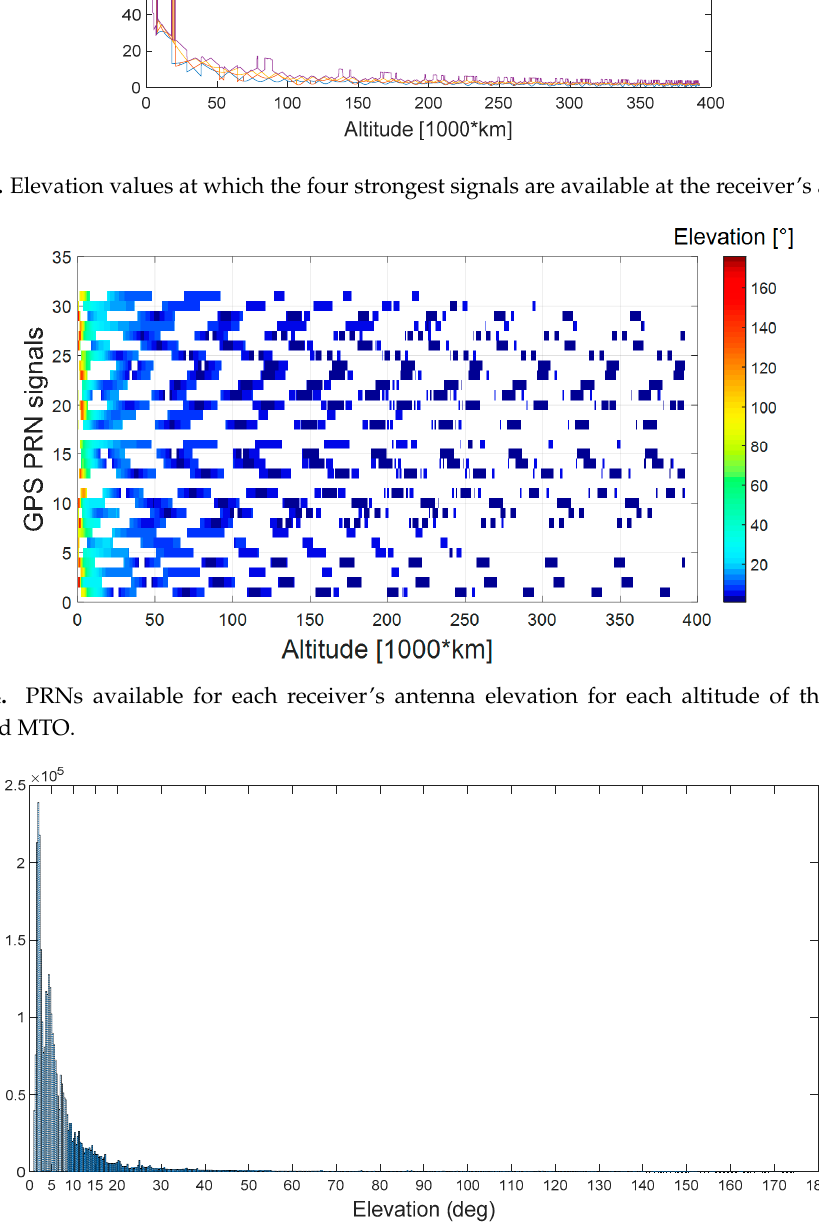
Figure 35. Histogram of the available observations for each receiver’s antenna elevation during the whole considered MTO.